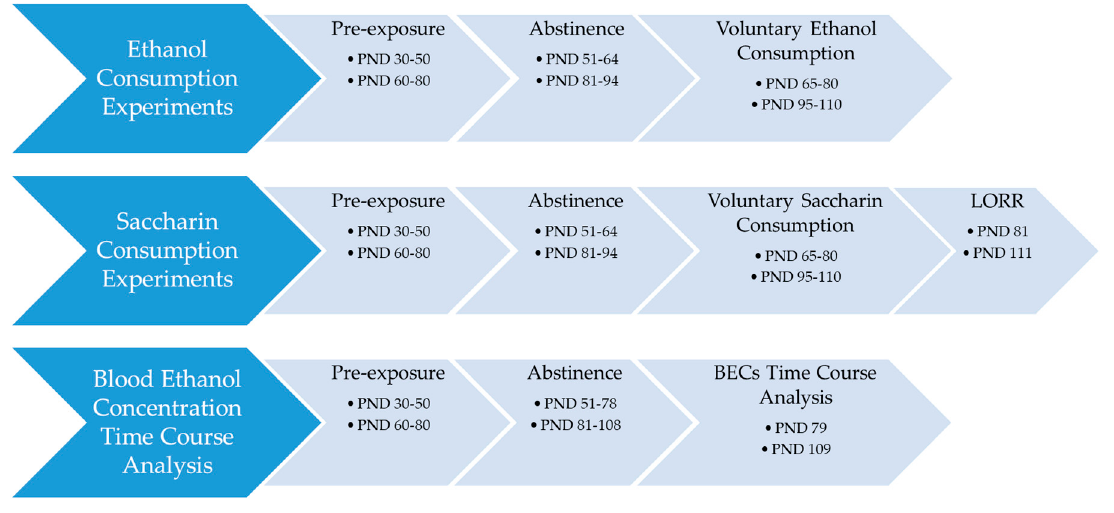
Figure 1. Timeline for each set of experiments.